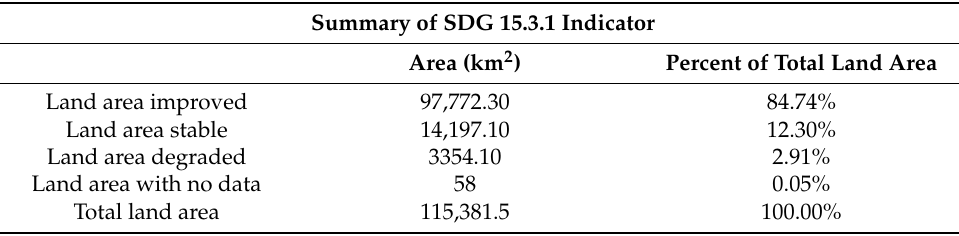
Table 2. Sustainable Development Goals 15.3.1: Land Degradation Neutrality in Mu Us. Summary of SDG 15.3.1 Indicator